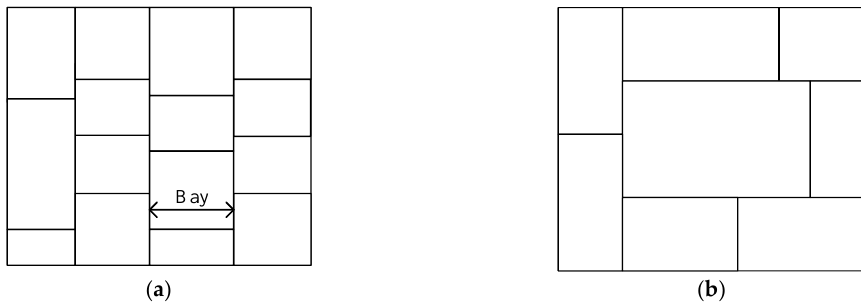
Figure 3. Layout representation. ( a ) Flexible bay structure; ( b ) Slicing tree structure.